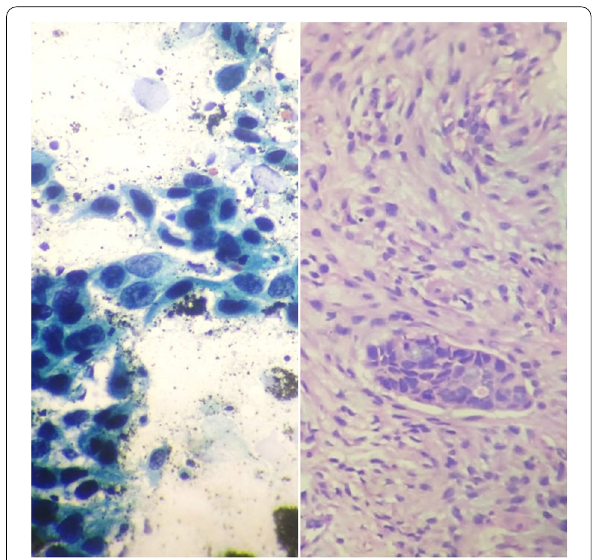
Fig. 1 Squamous cell carcinoma lung (MGG stained-squash smear cytology and H&E-stained histology slide); 100